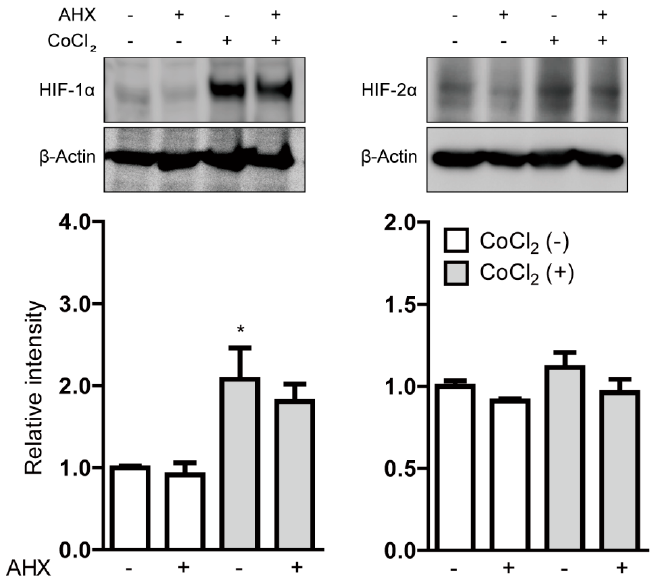
Figure 2. The inhibitory effect of AHX on HIF stabilization. The representative immunoblots and quantitative analyses ( n = 4 per group) for HIF-1 α , HIF-2 α and β -Actin showed that only HIF-1 α was stabilized in 661W cells under 200 µM CoCl 2 -induced pseudo-hypoxic conditions. Note that AHX did not significantly decrease the stabilized HIF-1 α expression. * p < 0.05 compared with no treatment. Bar graphs are presented as the mean with the ± standard error of the mean. The data were analyzed using one-way ANOVA followed by a Bonferroni post hoc test.